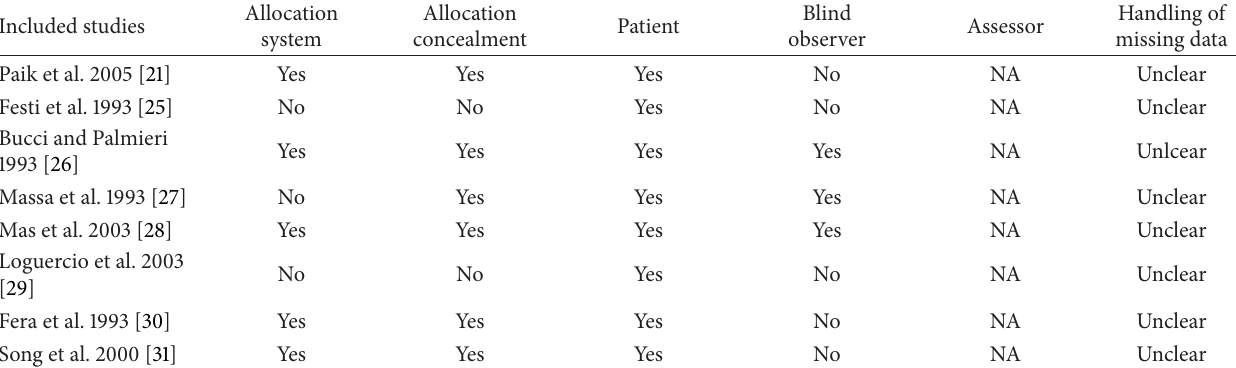
Table 2: Summary of methodological quality of included studies on the basis of review authors’ judgments.